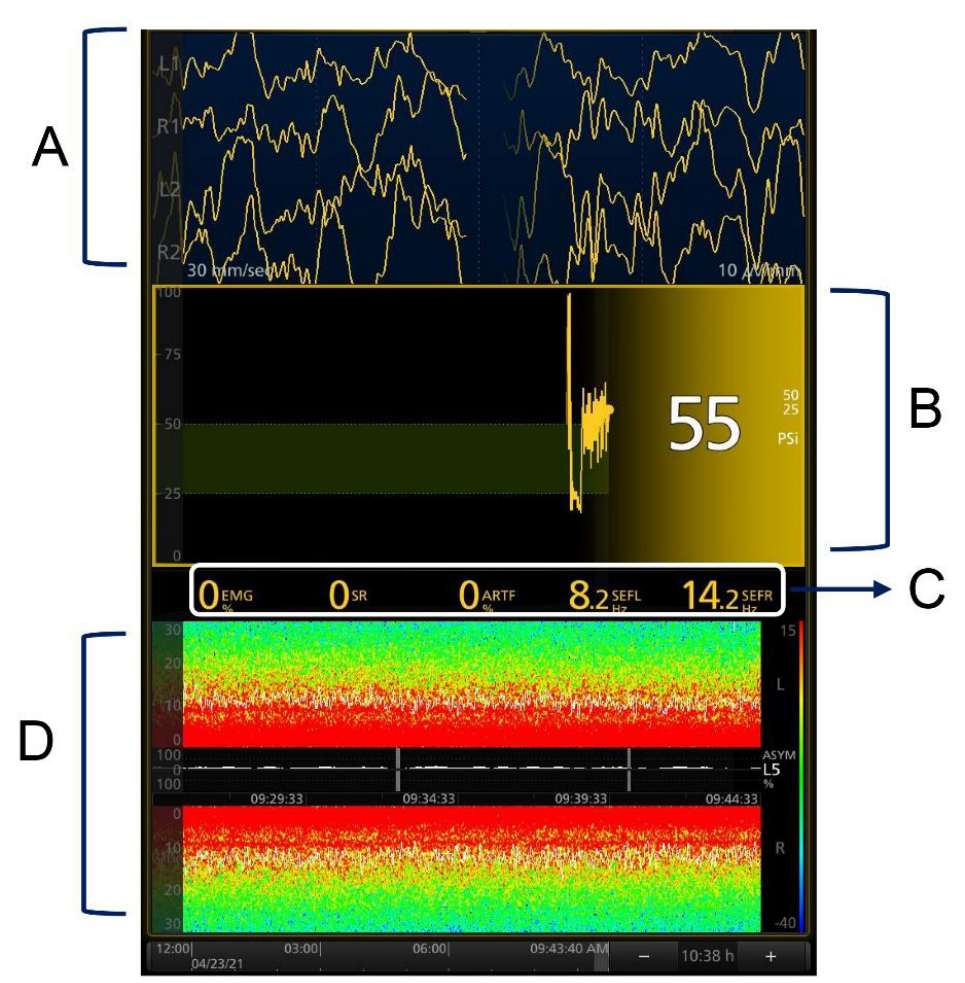
Figure 2. Interpretation of SedLine Monitor indices. ( A ) The four channels of EEG from top to bottom are, respectively, L1 (FP1), R1 (FP2), L2 (F7), and R2 (F8) synchronous electrical activities. ( B ) PSI, specific quantitative index of anesthesia depth. ( C ) Electromyography (EMG), which represents the measurement index of temporal muscle relaxation. SR, burst suppression; the presence of burst suppression indicates too-deep anesthesia. ARTF, percentage of false difference (interference). SEFL, SEFR; the distribution represents the spectral edge frequency of the left and right sides of the brain, which is the frequency range where 95% of the brain electrical activity is located. ( D ) DSA (density spectral array), which reflects the relationship between EEG power and frequency over time. The white line represents the spectral marginal rate including the SEF; the upper and lower parts are the spectral arrays of the left and right sides of the brain; and the color band on the right represents the power intensity. The higher the power, the brighter the spectral array in the frequency range where it is located.